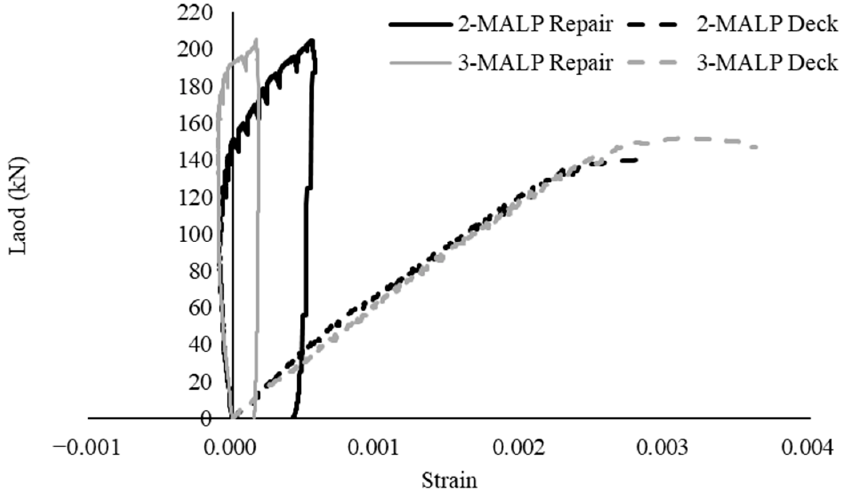
Figure 17. Load vs. deflection plot for connected girder specimens repaired with MALP.